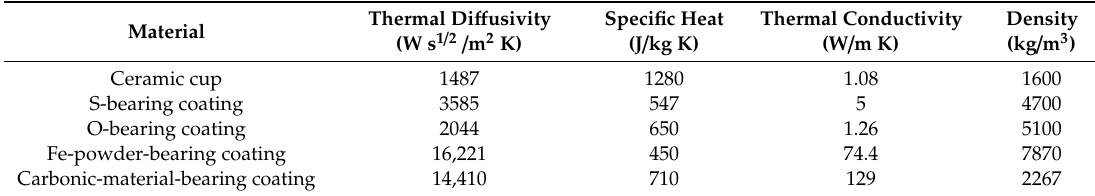
Table 3. Typical thermo-physical properties of used